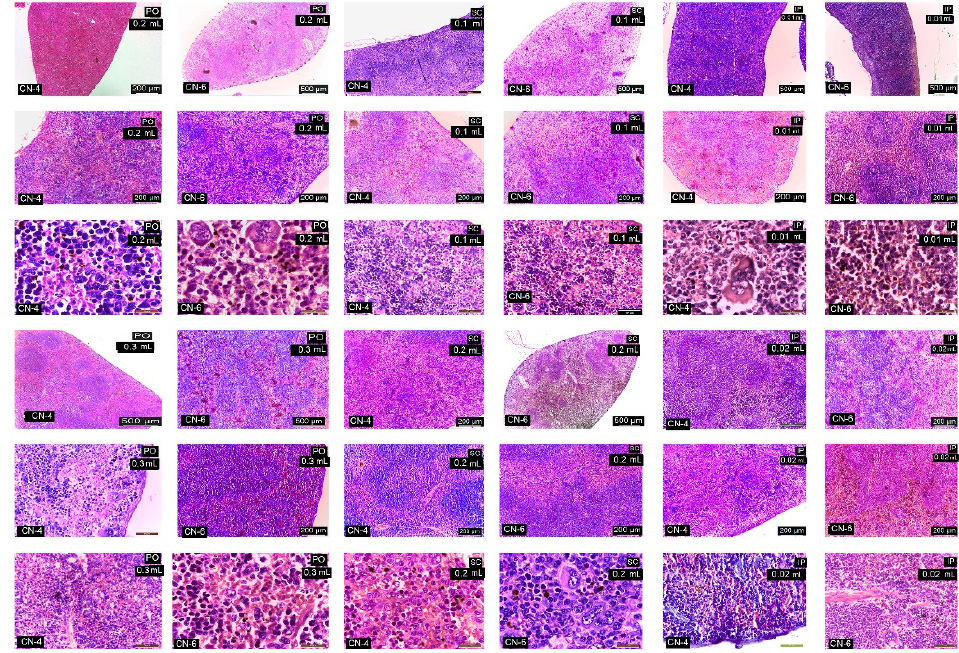
Figure 14. Spleen in the experimental group. HE staining.